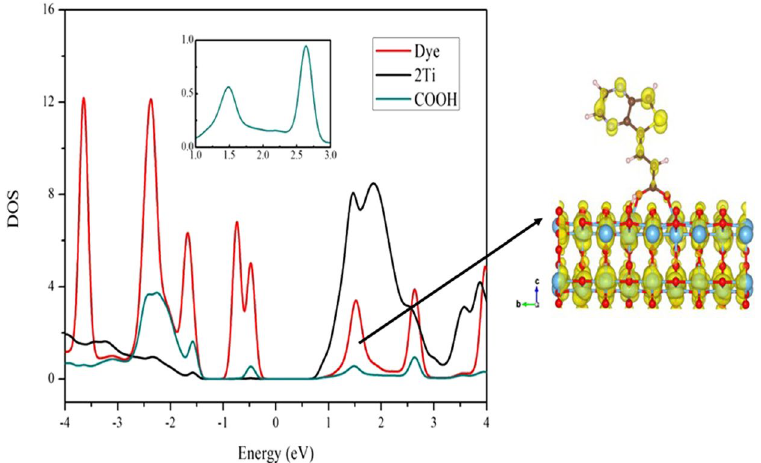
Figure 6. The DOS plot for the model dye adsorption configuration A3 along with its partial charge density for the band corresponds to long wavelength absorption band; isovalue 0.0004 a.u.